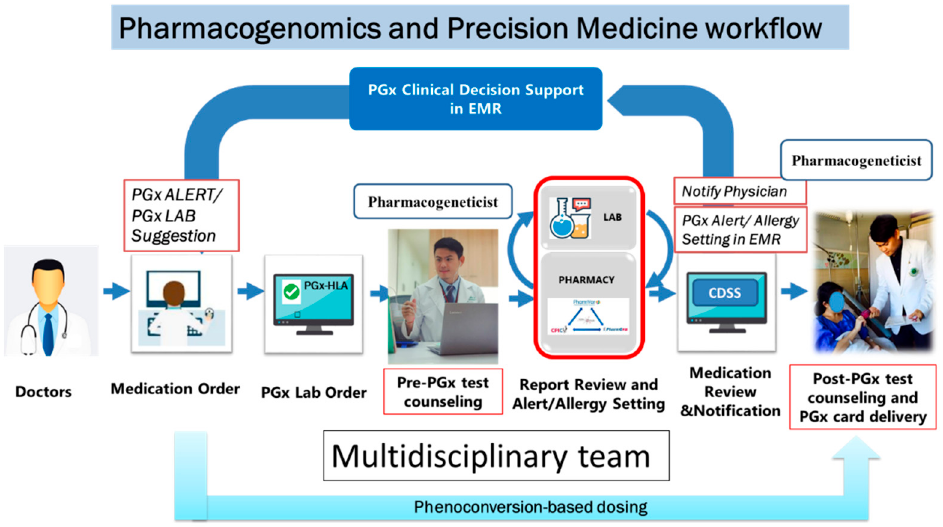
Figure 5. A systematic clinical workflow for implementation of HLA pharmacogenomics into routine clinical practice. HLA = Human leukocyte antigen, PGx = Pharmacogenomics; EMR-Electronic Medical Record, CDSS = Clinical Decision Support System .